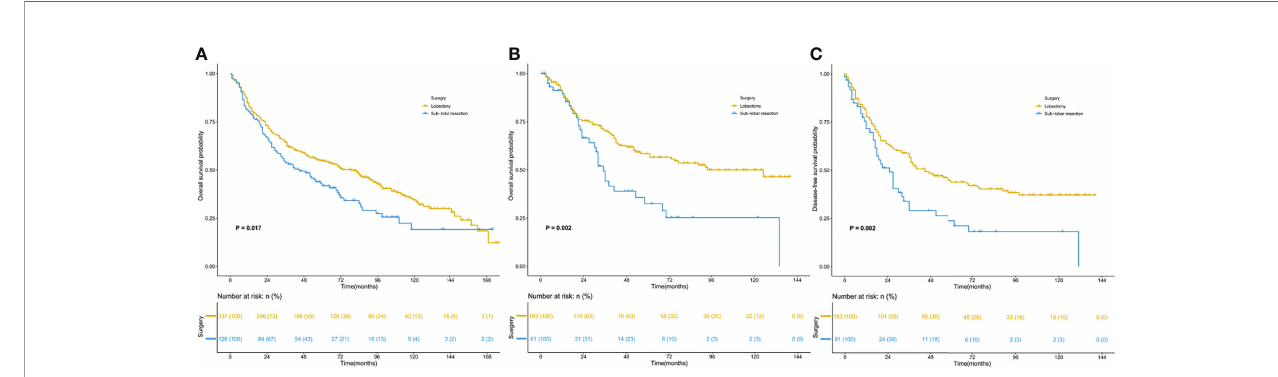
FIGURE 2 | Kaplan – Meier survival curves for patients with lung adenosquamous carcinoma. (A) overall survival of the SEER cohort; (B) overall survival of the SPH cohort; (C) disease-free survival of the SPH cohort. SEER, Surveillance, Epidemiology, and End Results; SPH, Shanghai Pulmonary